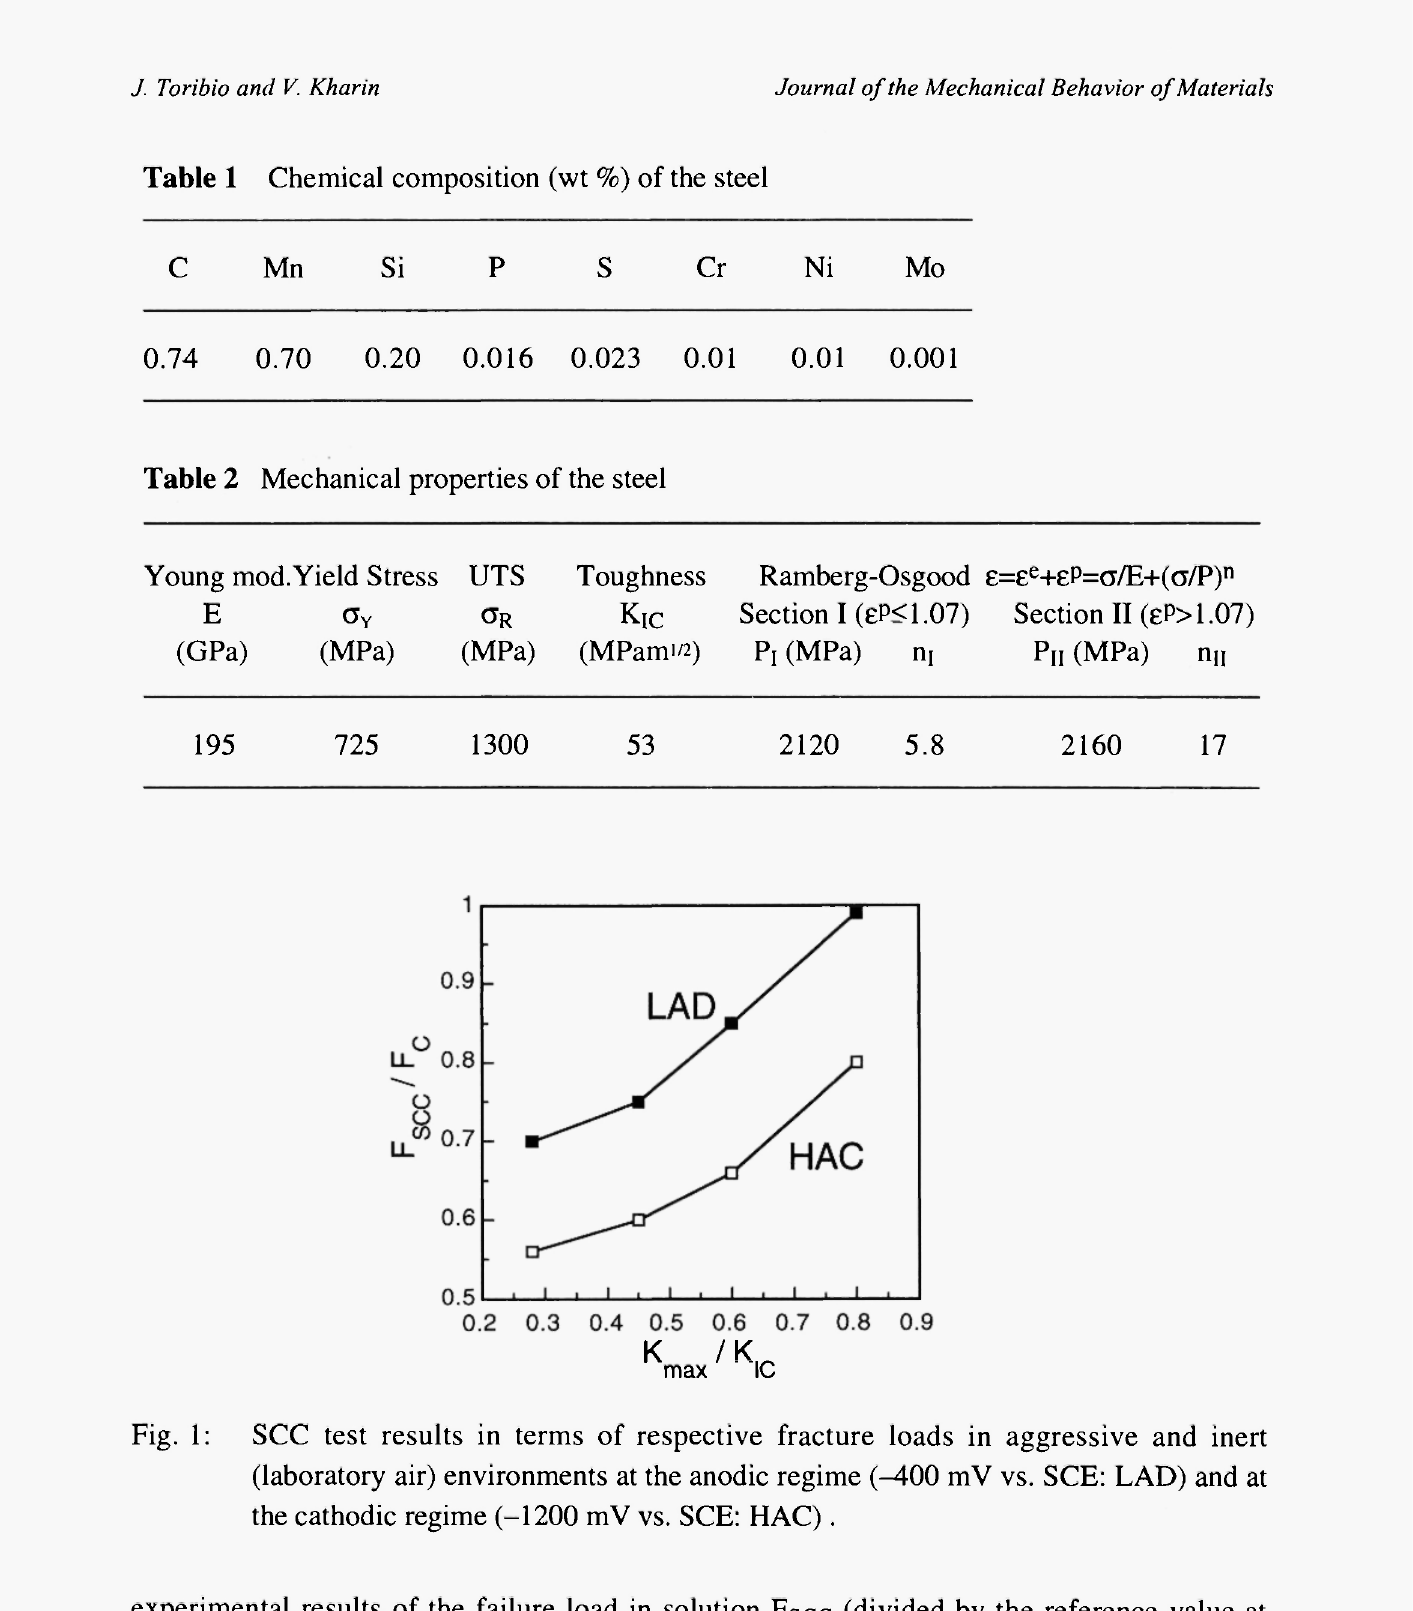
Fig. 1: SCC test results in terms of respective fracture loads in aggressive and inert (laboratory air) environments at the anodic regime (-400 mV vs. SCE: LAD) and at the cathodic regime (-1200 mV vs. SCE: HAC). experimental results of the failure load in solution Fscc (divided by the reference value at rupture in air Fc) as a function of the ratio K ma x /K[ . For both regimes of cracking, C